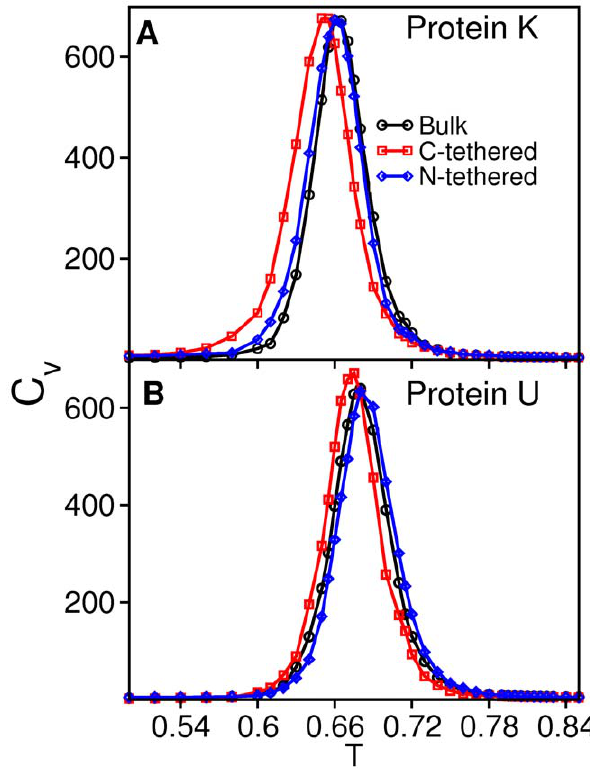
Figure 2. The heat capacity as a function of temperature in the considered folding setups. Panel (A) refers to the knotted protein and panel (B) to the unknotted one. The melting temperature T m is the temperature at which the heat capacity attains its maximum value.